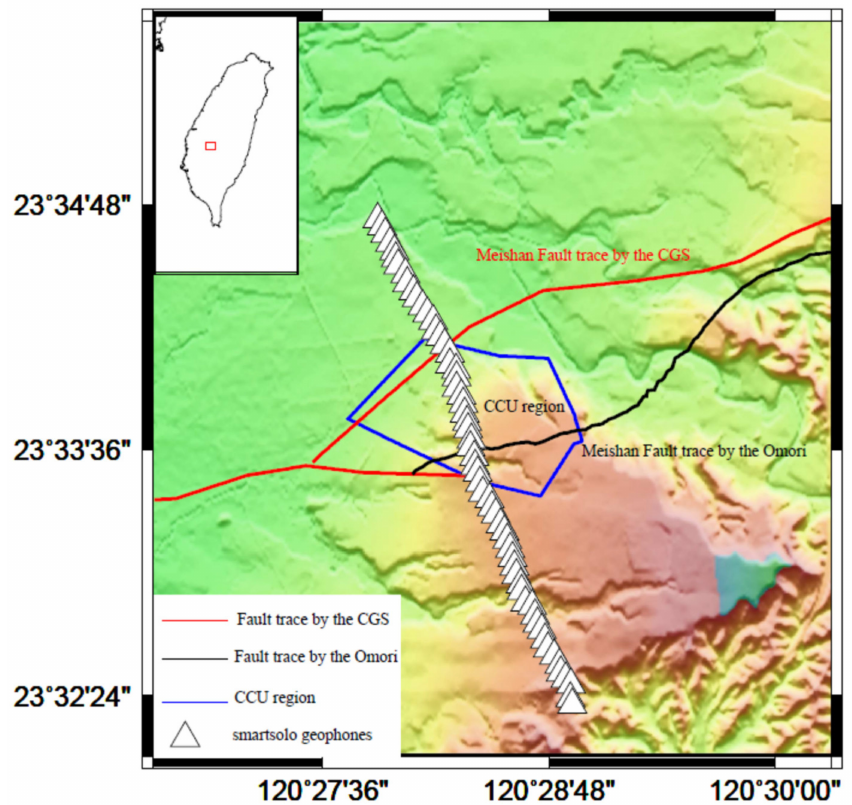
Figure 1. A topographic map showing the locations of the Meishan Fault, seismic stations, and the National Chung Cheng University (CCU) region. The blue box represents the CCU region, and the red and black lines indicated the fault traces of the Meishan Fault obtained by the CGS and Omori [3], respectively. The array of the sixty smartsolo geophones is represented by white triangles. The inset map shows the study area